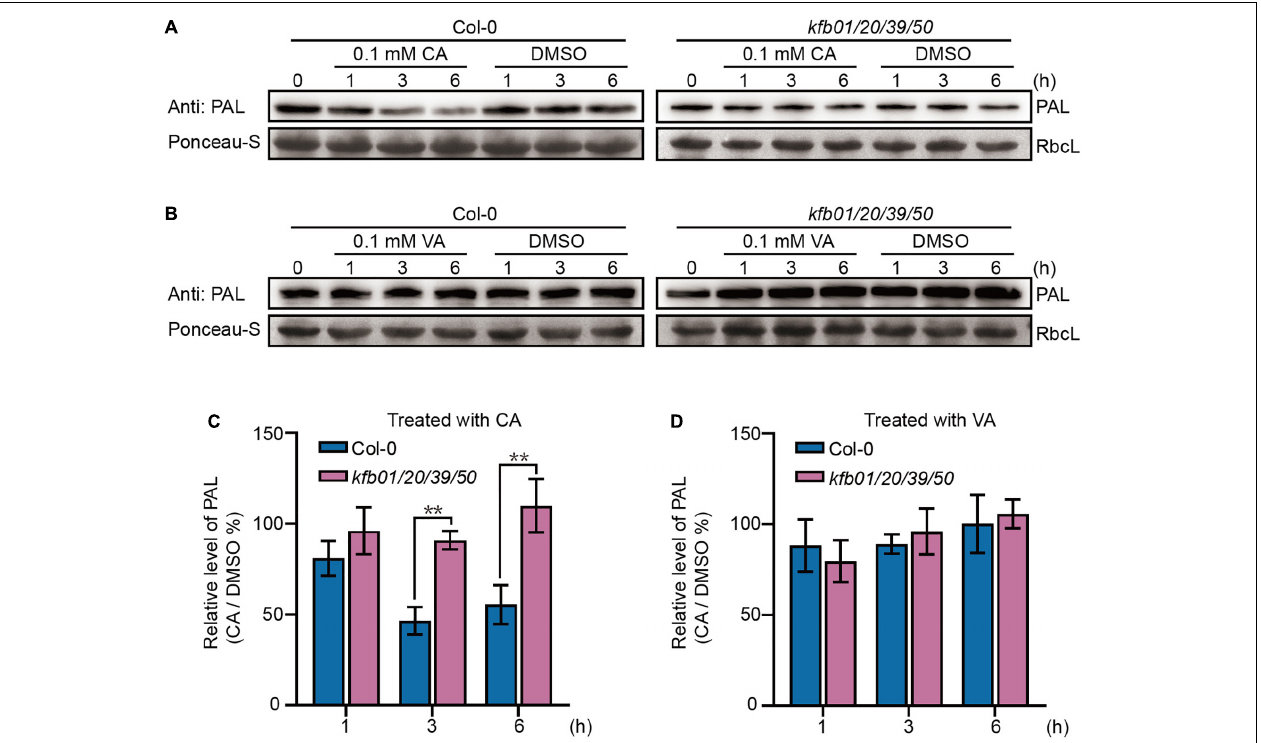
FIGURE 3 | Exogenous CA can specifically induce the degradation of PAL proteins in Arabidopsis. (A) Exogenous CA can induce the degradation of PAL proteins in Col-0 but not kfb01/20/39/50 . (B) Exogenous VA has no effect on the stability of PAL proteins in Col-0 and kfb01/20/39/50 . For (A,B) , 2-week-old seedlings were separately treated with solvent DMSO, 0.1 mM CA or 0.1 mM VA in 1/2 MS liquid medium for 1, 3, and 6 h, and the solvent DMSO was used as control. Ponceau staining of RbcL was shown as loading control. (C,D) Quantitative analysis of the band intensity in (A,B) . Protein contents were normalized to the corresponding content of RbcL by Ponceau staining. The relative level of PAL (CA/DMSO%) at 0 min was set to 100%. Error bars are means ± SD (Student’s t -test, ** P < 0.01, n =